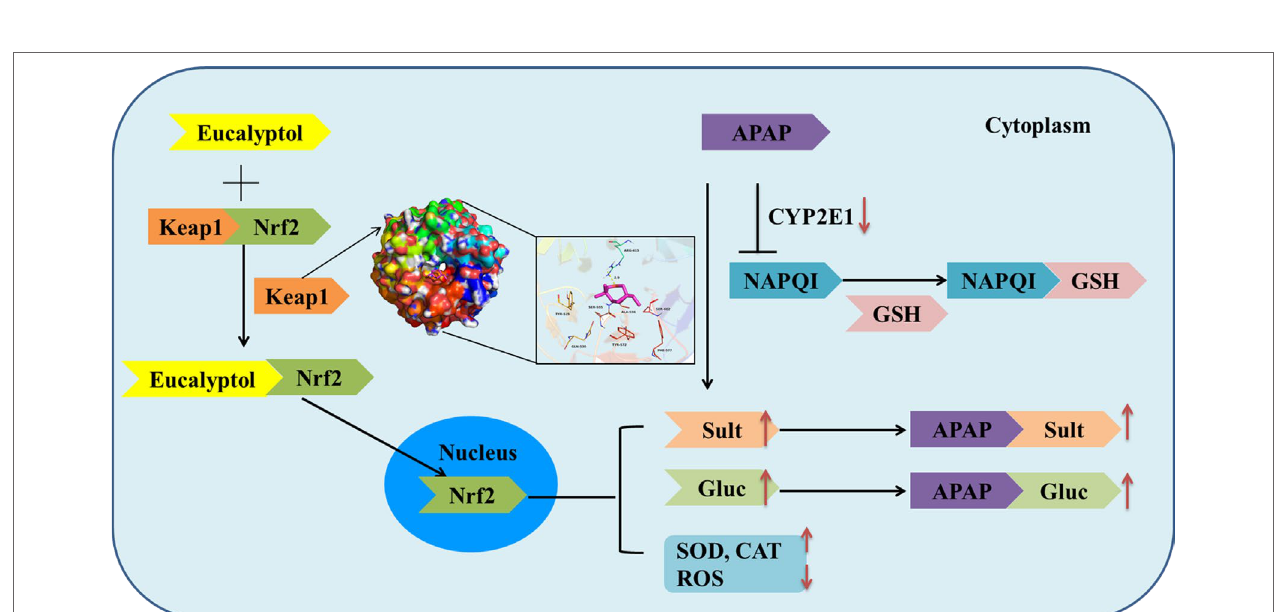
FIGURE 8 | Mechanism by which eucalyptol protects APAP induced liver